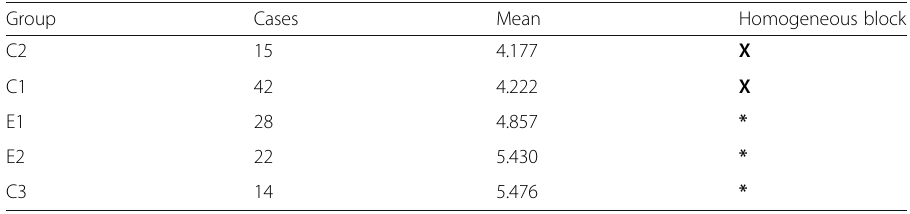
Table 3 Homogeneous blocks in terms of written production (pre-treatment) Group Cases Mean